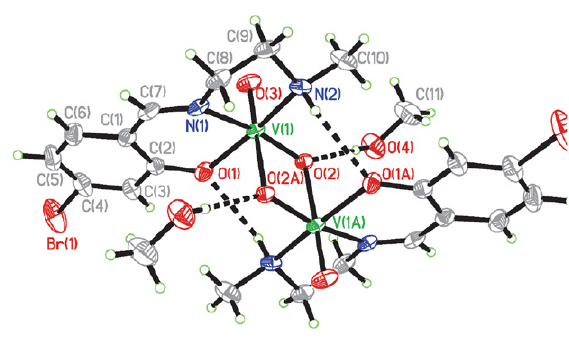
Fig. 7. Molecular structure of complex 4 . Atoms labeled with the suffix A are related to the symmetry operation 1/2 – x , 1/2 – y , 1 – z .